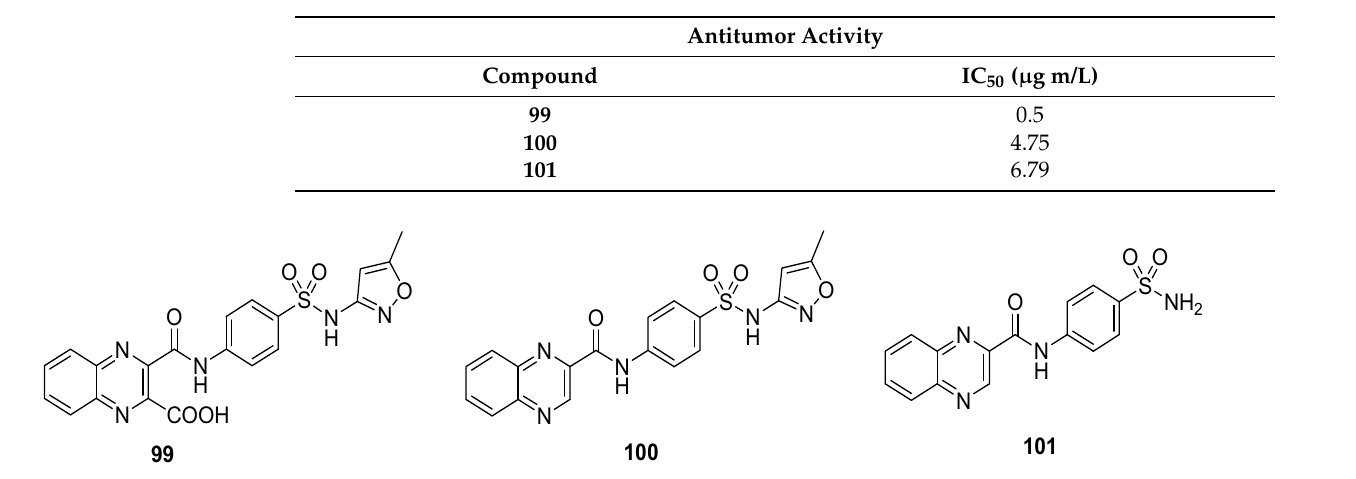
Figure 14. Substituted quinoxaline sulfonamide derivatives 99–101 . Ingle and coworkers reported the synthesis of new anticancer quinoxaline sulfonamide derivatives. The 2,3-diphenylquinoxaline derivative 56 was treated with electrophilic com- pound 47 to produce 2,3-diphenyl quinoxaline-6-sulfonylchloride 57 that further refluxed with primary amines in a basic medium and resulted in the formation of the desired final product, substituted quinoxaline sulfonamides 58 at 53–78% yield (Scheme 10) [136].